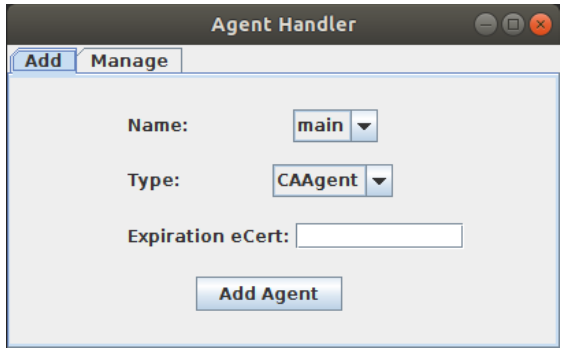
Figure 4. View to add the agents.